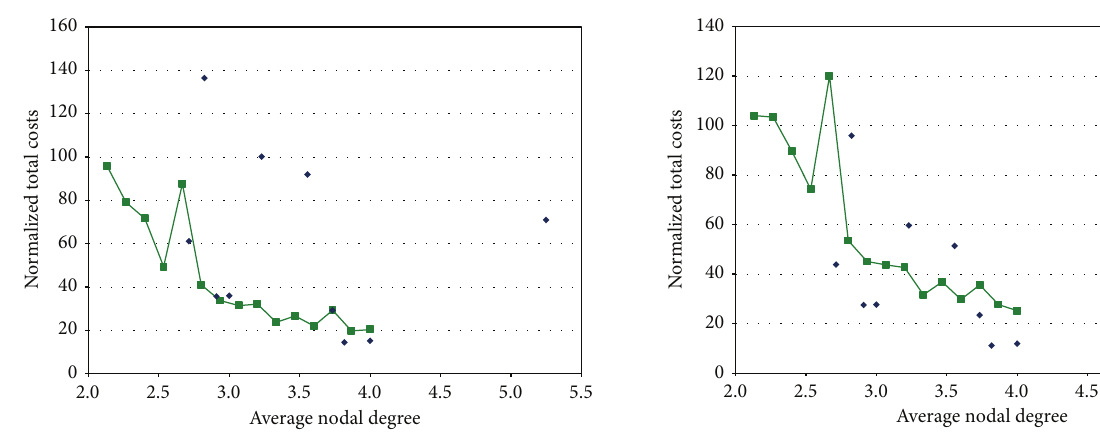
Figure 18: Normalized p -cycle restorable SCA spare capacity costs.